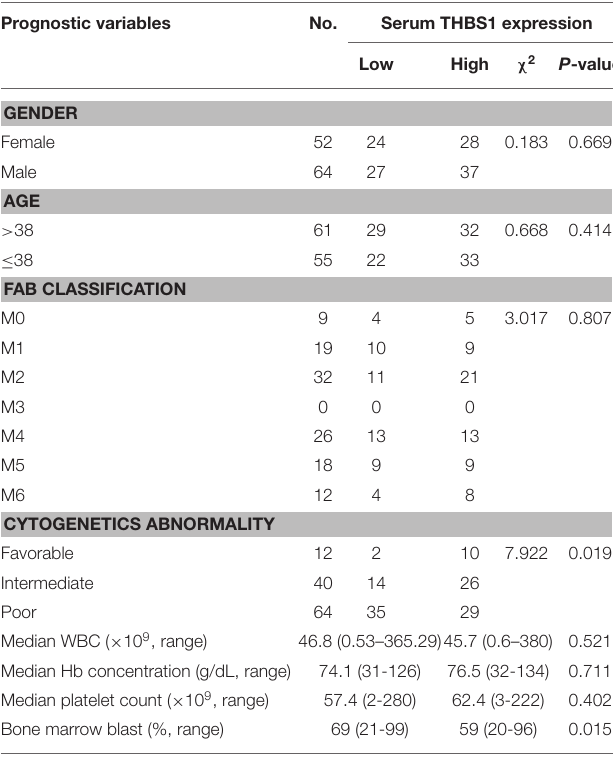
TABLE 1 | Correlation between THBS1 protein and clinicopathological features of AML